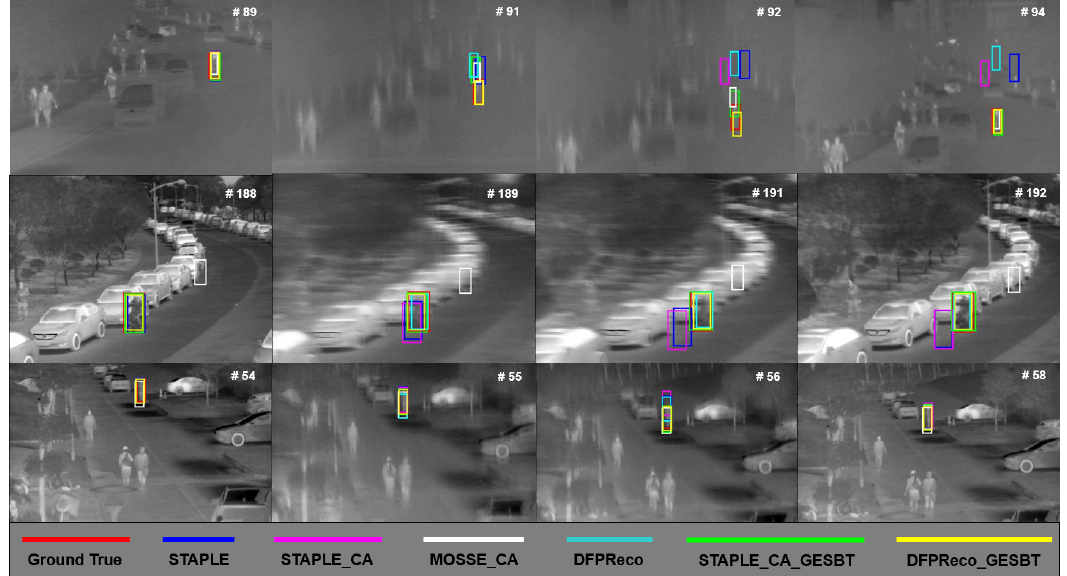
Figure 11. Qualitative examples of baseline trackers and their extension with the proposed